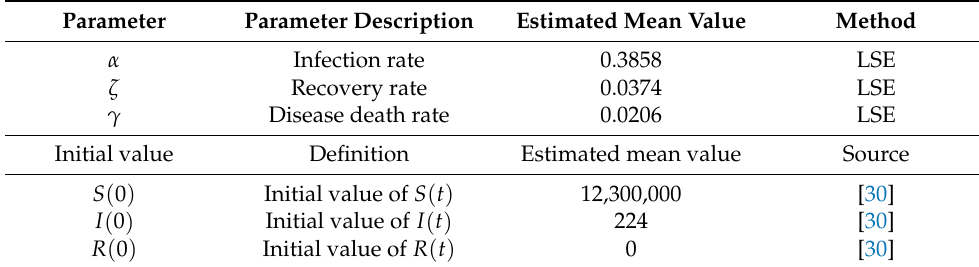
Table 2. COVID-19 model parameter estimation of